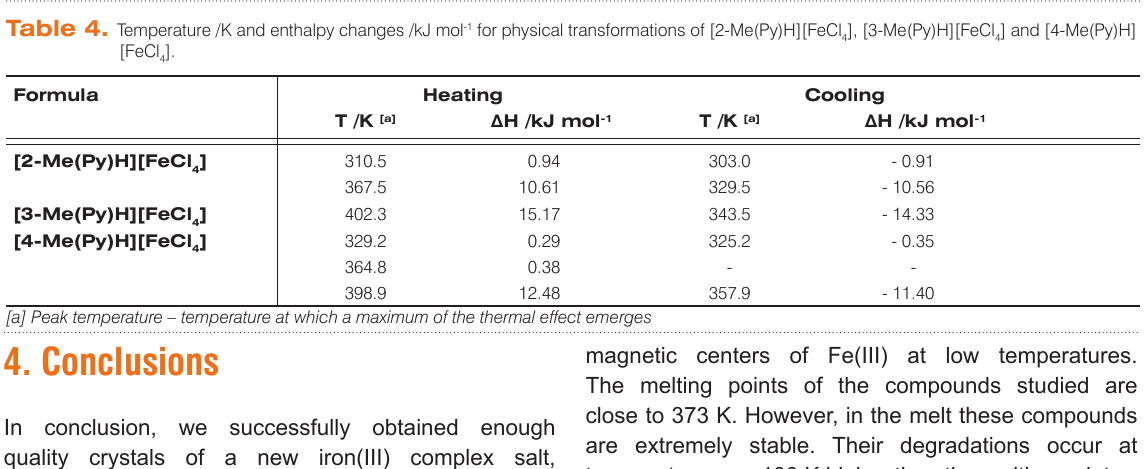
Table 4. Temperature /K and enthalpy changes /kJ mol -1 for physical transformations of [2-Me(Py)H][FeCl